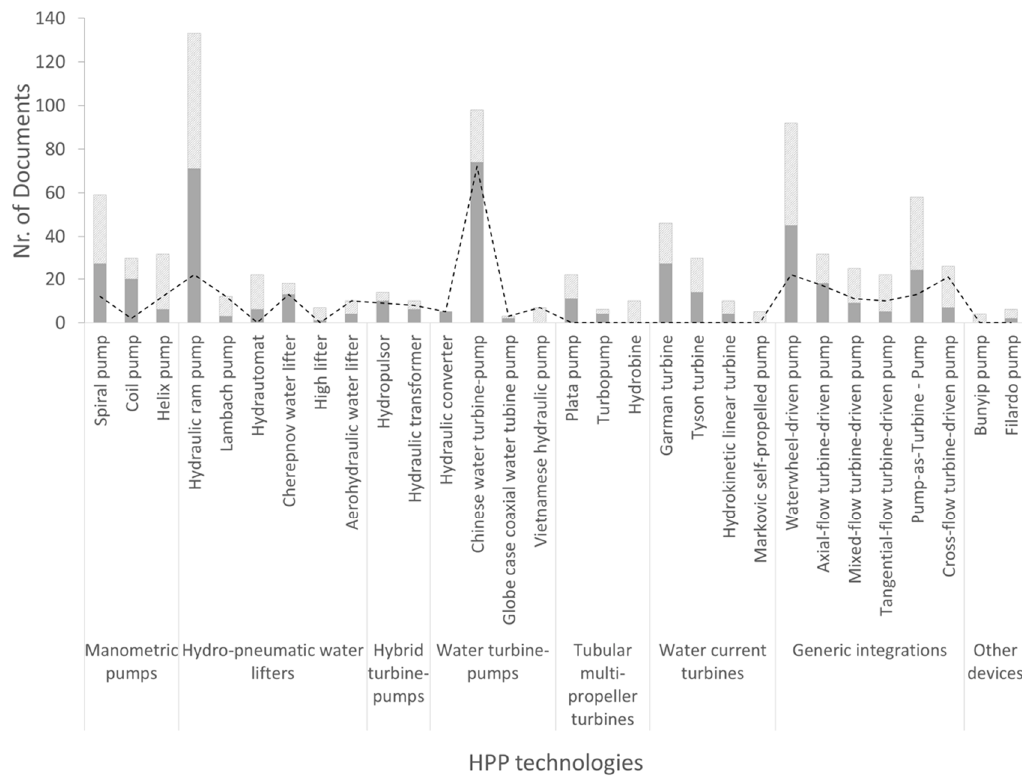
Figure 10. Number of selected documents per HPP technology. The grey solid bars, grey diagonal pattern bars, and black dashed line correspond to scientific literature, grey literature, and non-English literature (both scientific and grey), respectively.